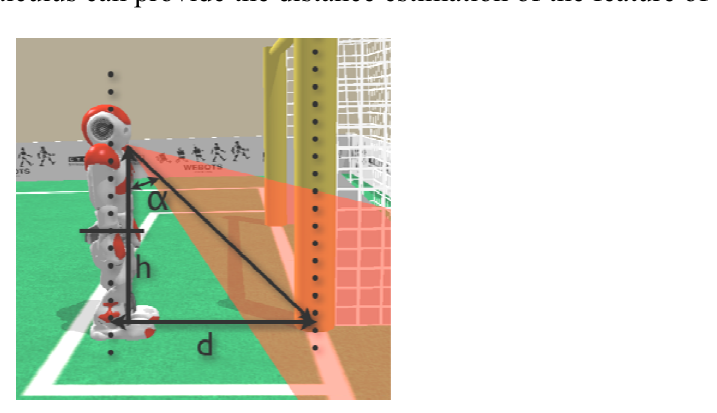
Figure 8. A simple geometrical calculus can provide the distance estimation of the feature of